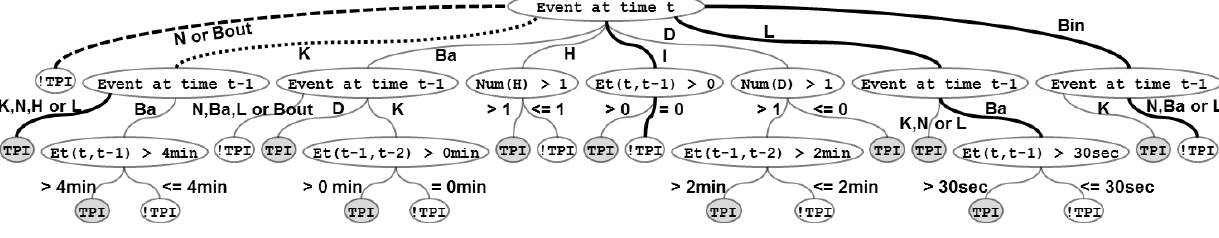
Figure 7. A decision tree distinguishes different time periods during the night. Notation: Ba, bathroom; K, kitchen; H, hallway; L, living room; I, inactivity; D, door openings; Bin, bed entrances; Bout, bed exit; N, lack of events. TPI, Time Period I; !TPI, not Time Period